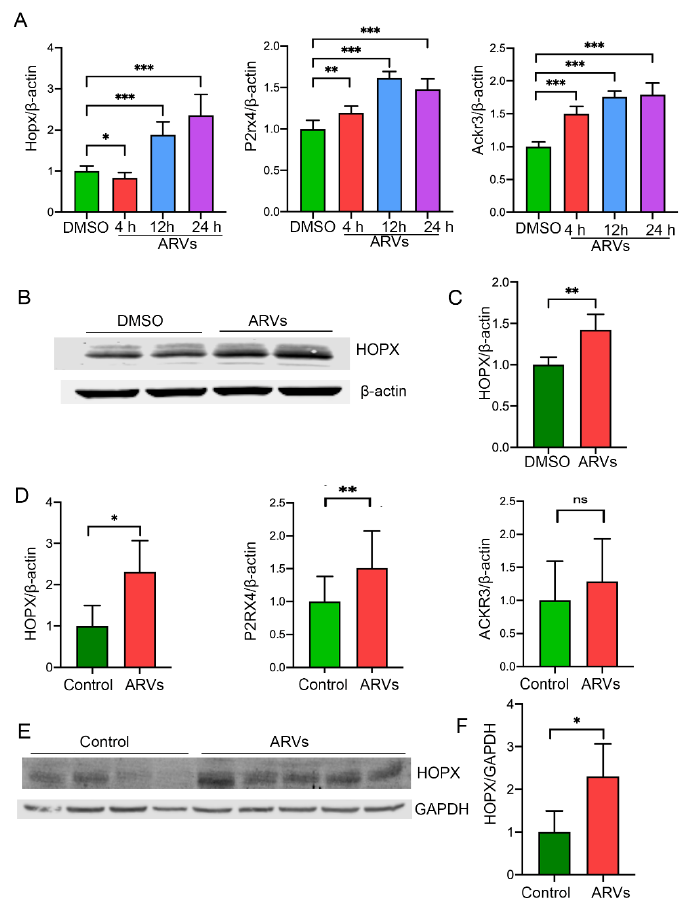
Figure 2. ARV treatment promotes HOPX expression in cardiomyocytes and human cardiac tissue. NRVCs were treated with 5 uM ARVs (combination of Ritonavir, Atazanavir, Abacavir, and